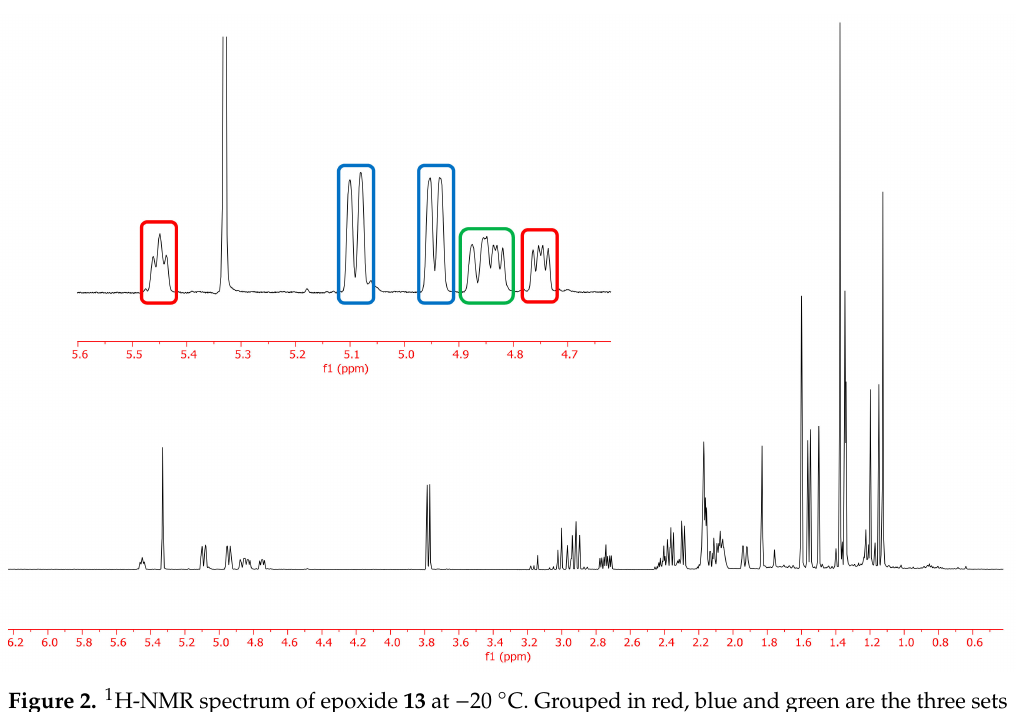
Figure 2. 1 H-NMR spectrum of epoxide 13 at − 20 ◦ C. Grouped in red, blue and green are the three sets of olefinic signals attributable to the three conformers of this molecule existing in solution.